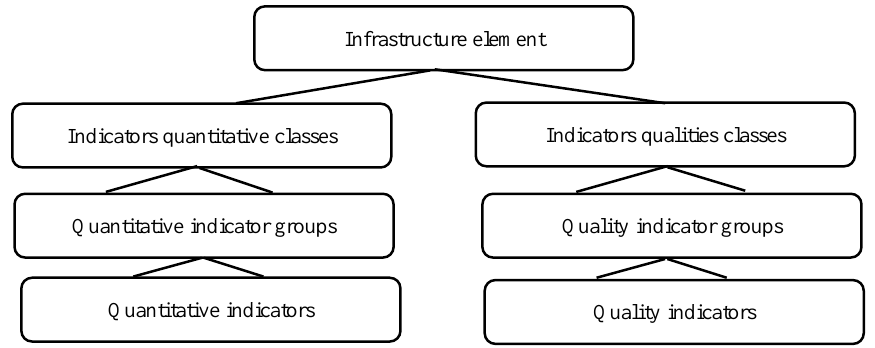
Fig. 2. A hierarchical model of indicators.